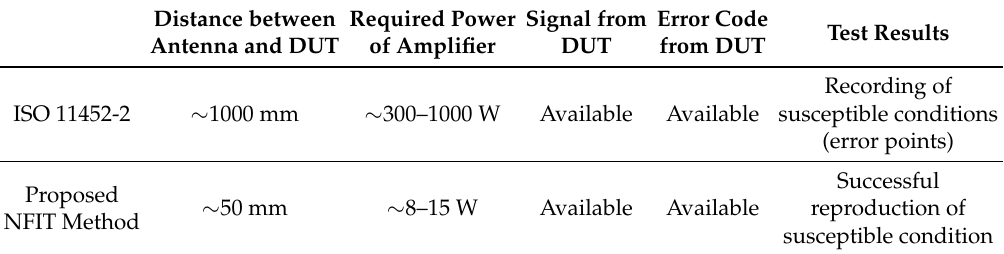
Table 3. Comparison of the two immunity test